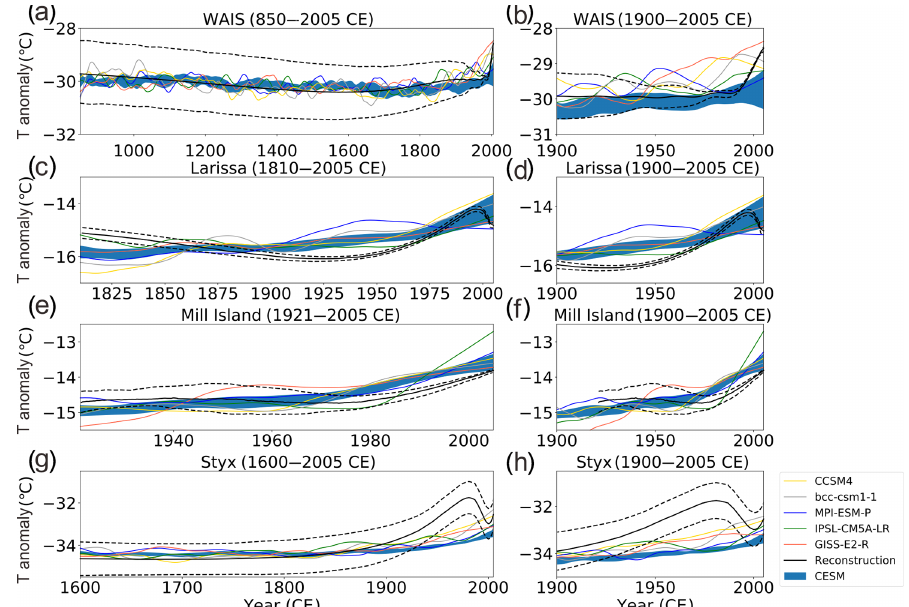
Figure 3. Comparison between reconstructed surface temperature series from boreholes and the climate model outputs at the grid cell closest to each borehole site. The borehole reconstructions are in black and their uncertainty ranges given by the dashed lines. Color lines correspond to the climate model results. The shaded area represents the mean ± 1 standard deviation of CESM model ensemble. For the left column, a 50-year LOWESS has been applied for the WAIS and Styx time series; Larissa and Mill Island are smoothed using 10- and 3-year windows, respectively. The time series in the right column is smoothed using 3-year windows from 1900 to 2005 CE.